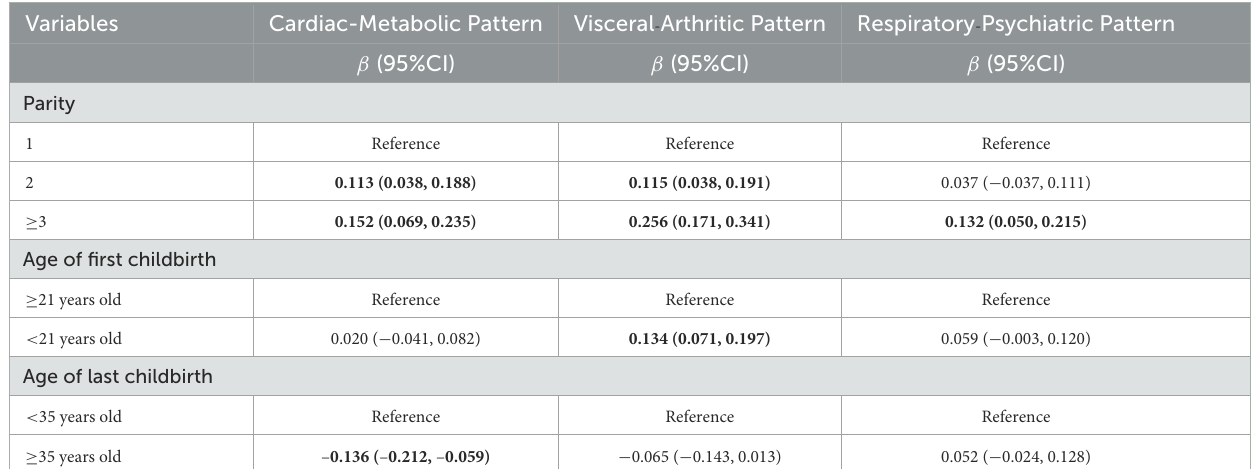
TABLE 4 Association between female fertility history and factor scores of multimorbidity